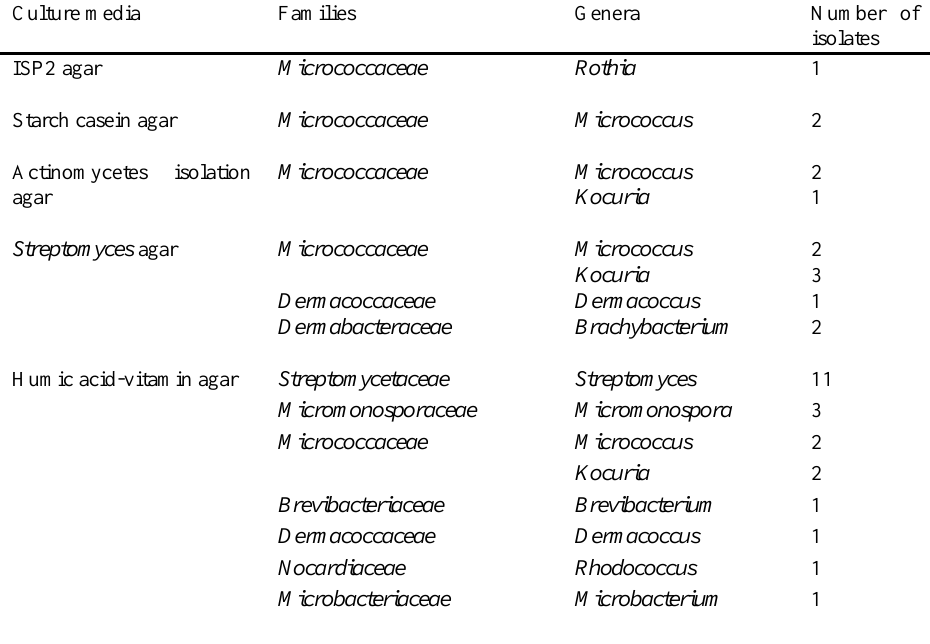
Table 3: Taxa of Actinobacteria recovered on five different isolation